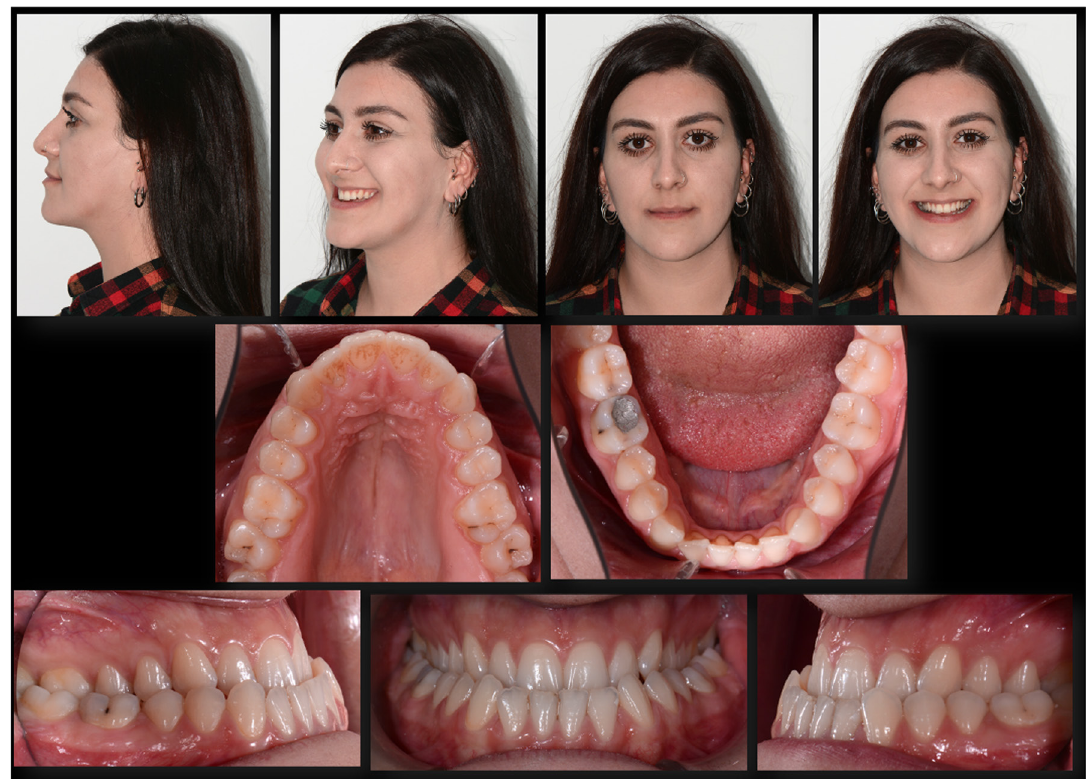
Figure 1. Pre-treatment extraoral and intraoral